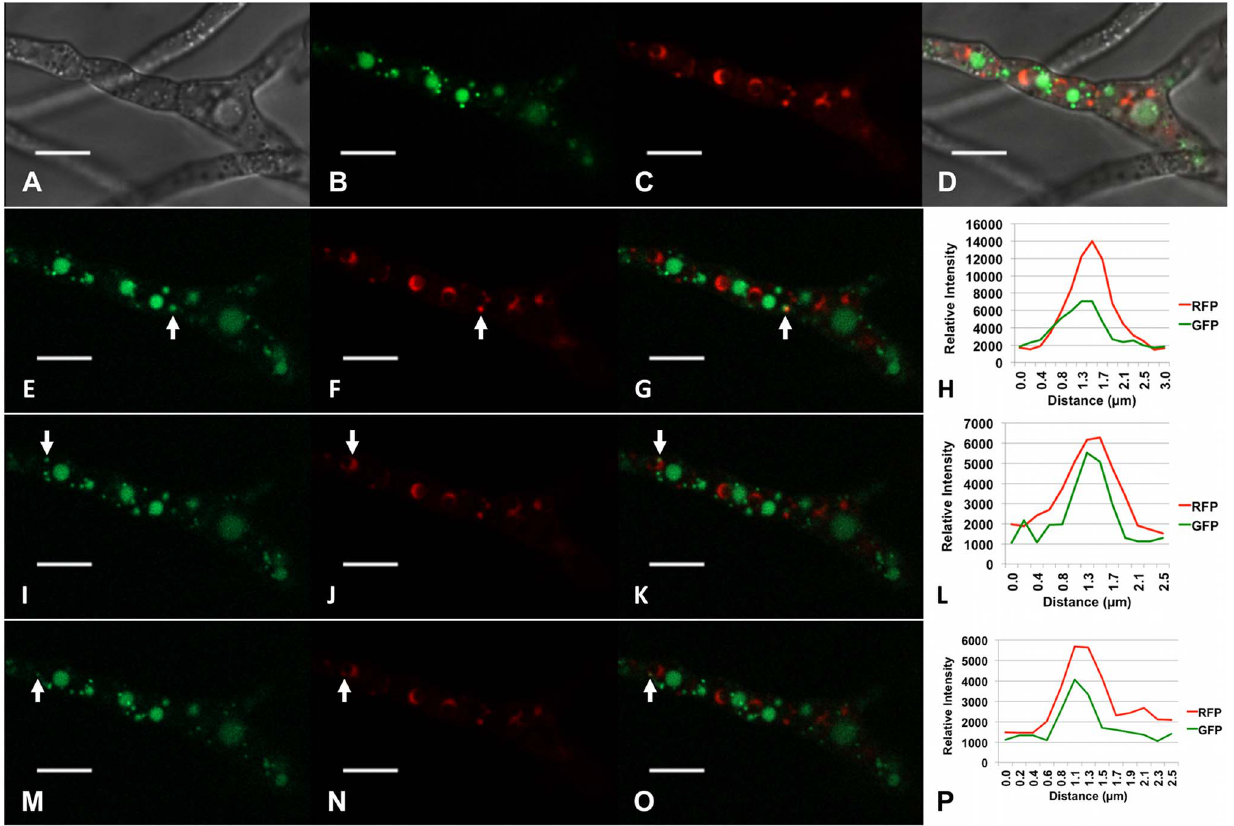
Figure 3. Interactions between toxisomes and Tri12p::GFP labeled vesicles. Co-localization of Tri4p::RFP labeled organelles and motile Tri12p::GFP labeled vesicles within strain PH-1Tri4::RFP/Tri12::GFPB under conditions where trichothecene biosynthesis occurs. Confocal bright field DIC (A); GFP (B, E, I, M); RFP (C, F, J, N); GFP/RFP/DIC overlay (D); and GFP/RFP overlay images (G, K, O) are shown. These images show strain PH- 1Tri4::RFP/Tri12:GFPB co-expressing Tri4p::RFP and Tri12p::GFP fusion proteins 36 h after suspension in TBI medium. Signal intensity of GFP and RFP emission spectra (H, L, P) were generated from a line bisecting each organelle labeled (arrows) in panels E–G, I–K; and M–O. Panels E–G, I–K, and M–O show images of the same culture at different times. Images were captured from Video S2. Scale bar=10 m m.